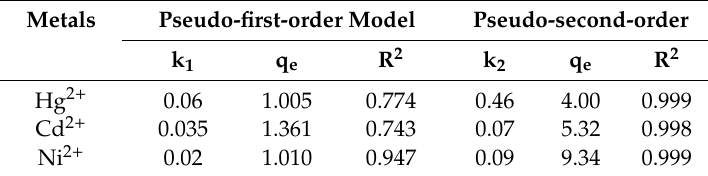
Figure 9. Adsorption kinetics model (Co wt % = 40%). ( a , c , e ) pseudo-first-order model (Hg 2+ , Cd 2+ , Ni 2+ ); ( b , d , f ) pseudo-second-order model (Hg 2+ , Cd 2+ , Ni 2+ ). Table 4. Adsorption kinetic